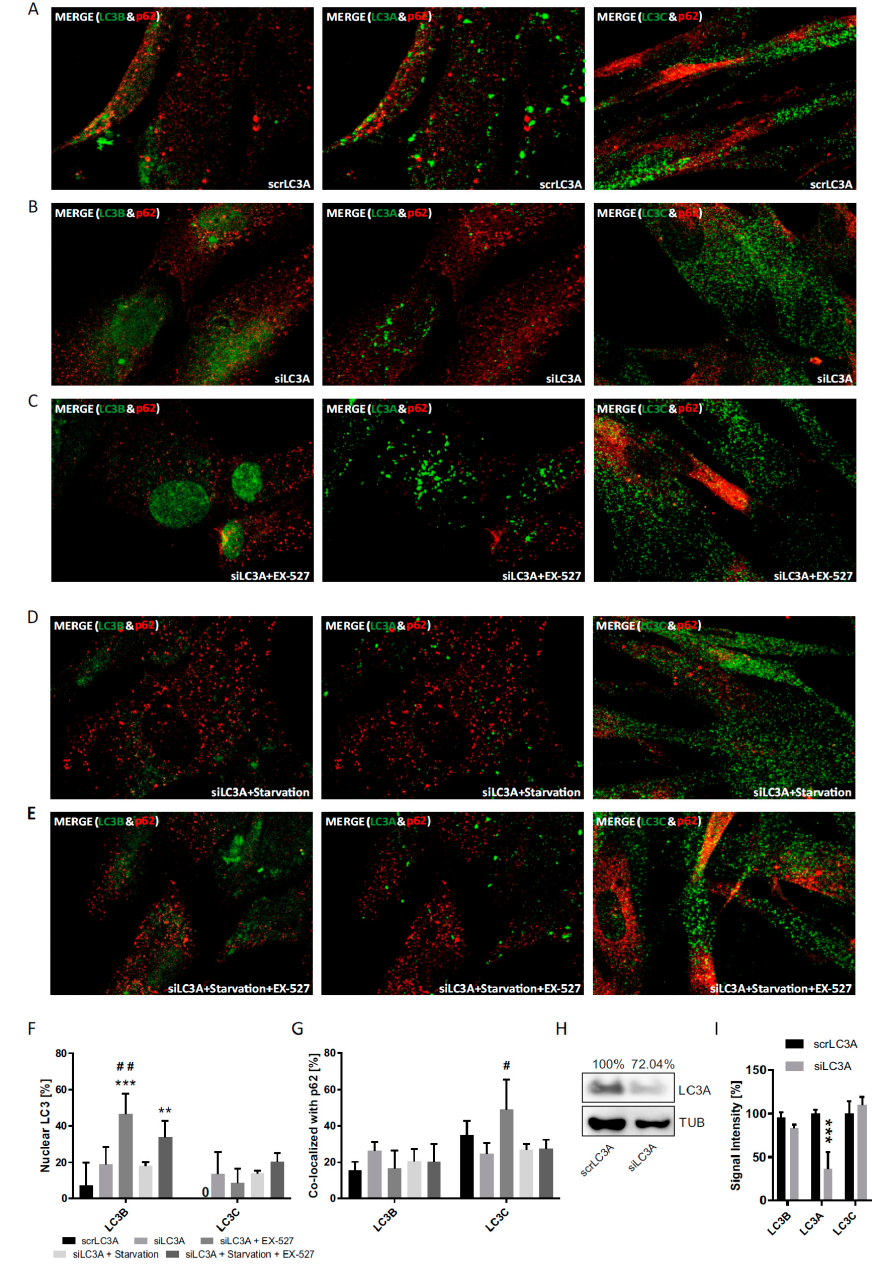
Figure 9. Analysis of the cellular localization of LC3A, LC3B, LC3C after siRNA-mediated LC3A knock-down. Primary human fibroblasts were treated with BafA1 after transfection with ( A ) scrLC3A-RNA and ( B ) siLC3A-RNA, (C) siLC3A-RNA and Ex527 treatment, ( D ) siLC3A-RNA and starvation, and ( E ) siLC3A-RNA and starvation and Ex527 treatment. ( F ) Quantification of the relative nuclear fraction of LC3B and LC3C in cells treated as indicated. ( G ) Relative co-localization of LC3B and LC3C with p62 quantified by image analysis. Significant changes (by two-way ANOVA) versus scrLC3A: ** p ≤ 0.01; *** p ≤ 0.001; significant changes versus siLC3A: # p ≤ 0.05; ## p ≤ 0.01. ( H ) LC3A protein expression in cells transfected with scrLC3A-RNA or siLC3A-RNA. Tubulin was used as loading control. ( I ) Control of knock-down and antibody specificity under immunocytochemistry conditions. Whole-cell signal intensities were quantified and evaluated by two-way ANOVA. Data in ( F ), ( G ) and ( I ) were derived from three photographed, independent experiments ( n = 3), in which 12–45 cells per image were